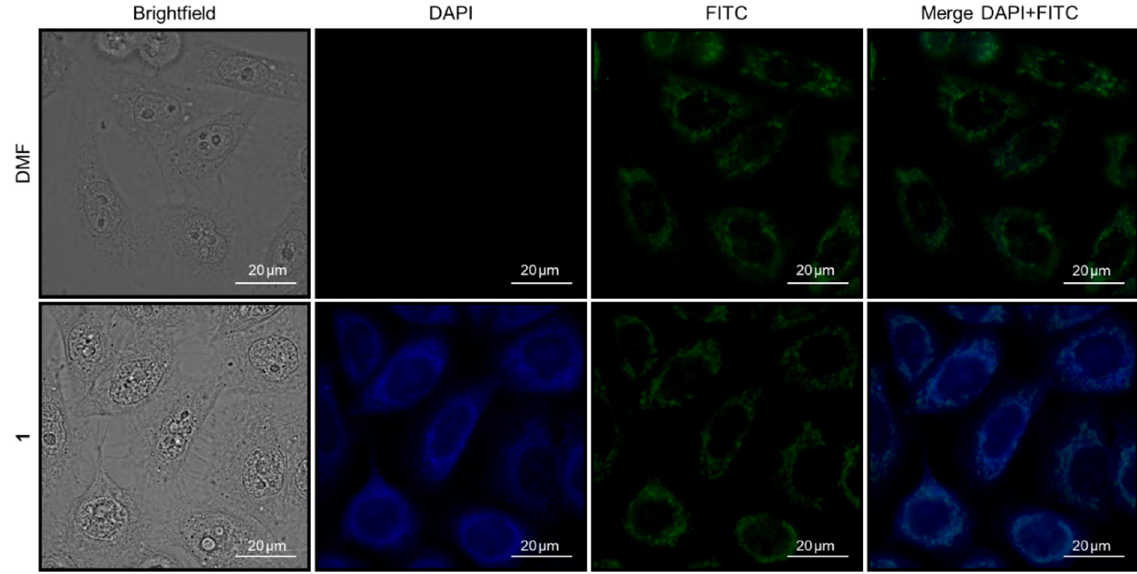
Figure 13. Representative images of Siso cells treated with either DMF or pentathiepin 1 (IC 90 ) for 24 h prior to imaging with a Leica fluorescence microscope with a 63 × oil immersion objective. The distribution of 1 was visualized in the DAPI channel ( λ ex = 325–407 nm, λ em = 461 nm), and the autofluorescence of the cells in the FITC channel ( λ ex = 488 nm, λ em = 525 nm). Cell morphology was imaged in bright field